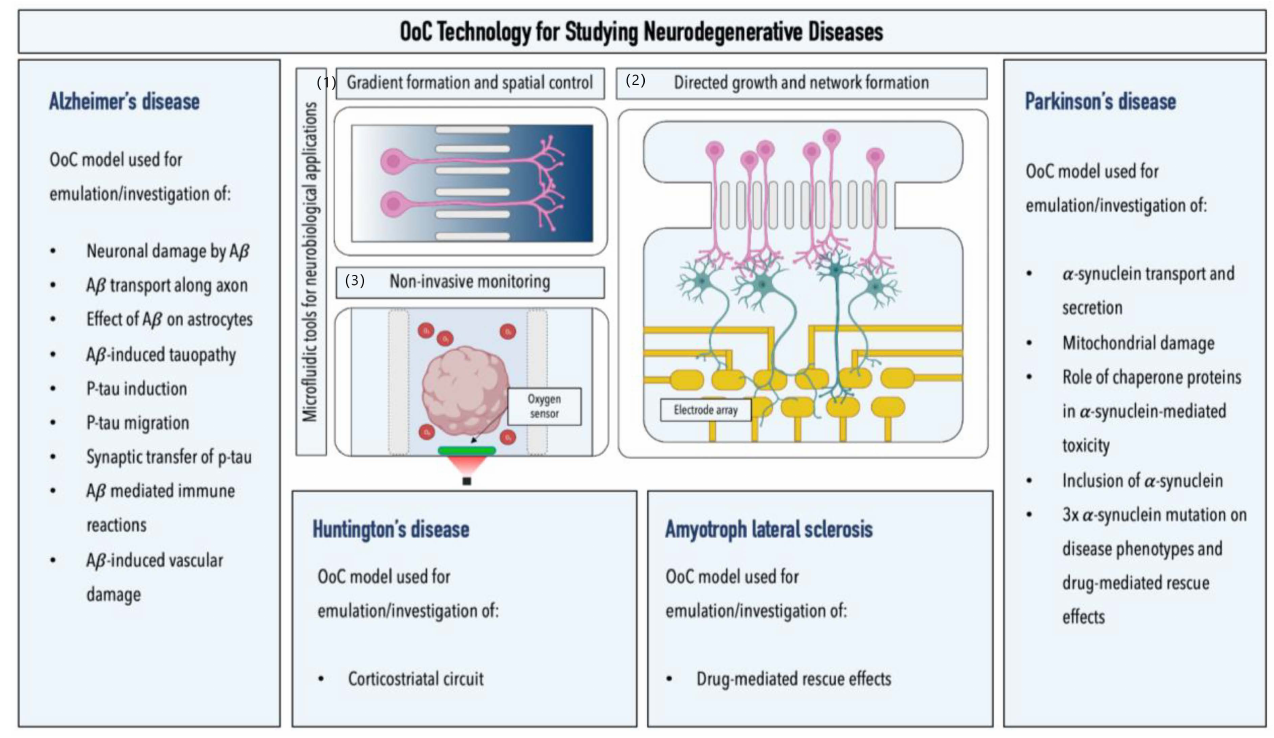
Figure 4. Overview of microfluidic models for studying neurodegenerative diseases. Graphical illustrations highlight the advantages of microfluidic setups for studying neurodegenerative diseases: ( 1 ) generation of biochemical gradients (image illustrates two interconnected microfluidic channels with varying concentrations); ( 2 ) noninvasive monitoring of cells of the neurovascular unit by the integration of electrical, optical, and electrochemical sensors (image illustrates a brain organoid-on- a-chip platform equipped with integrated luminescent oxygen sensor spots for recording cellular respiration); and ( 3 ) directed growth and network formation (image illustrates two interconnected microfluidic chambers that allow for the directed growth and functional connection of two spatially separated neuronal populations; an integrated multielectrode array allows for the electrophysiological recording of neuronal activity in the downstream chamber of the